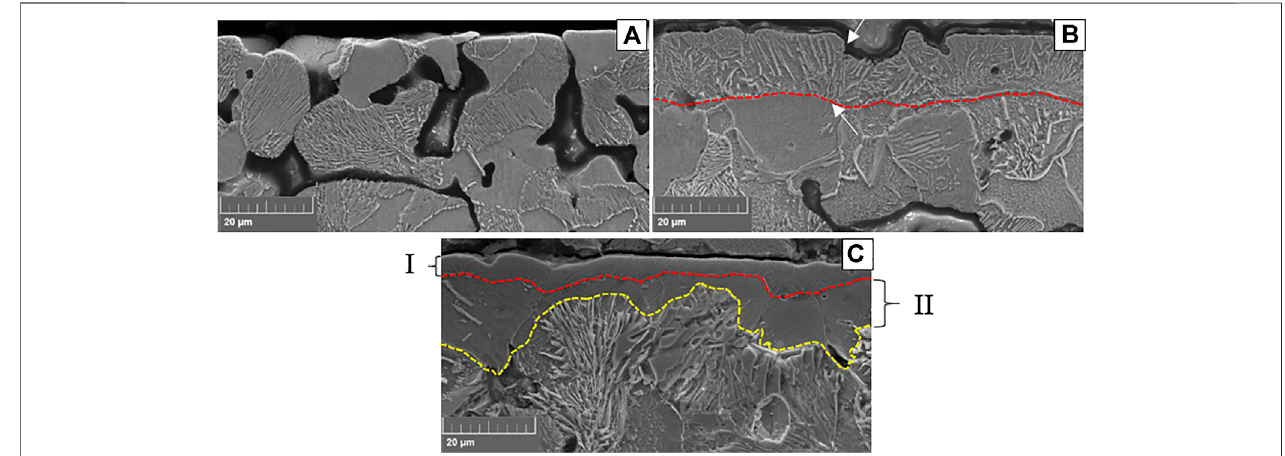
FIGURE 4 | SEM micrographs of cross sections of (A) the S.G sample, (B) Mo.G sample, and (C) Ni.G sample. Nital 2%.